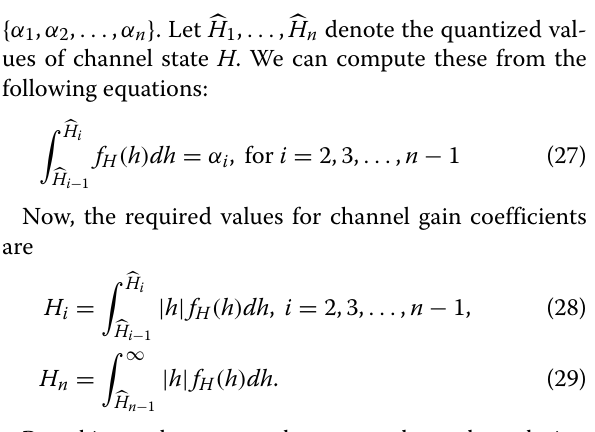
n denote the quantized val-